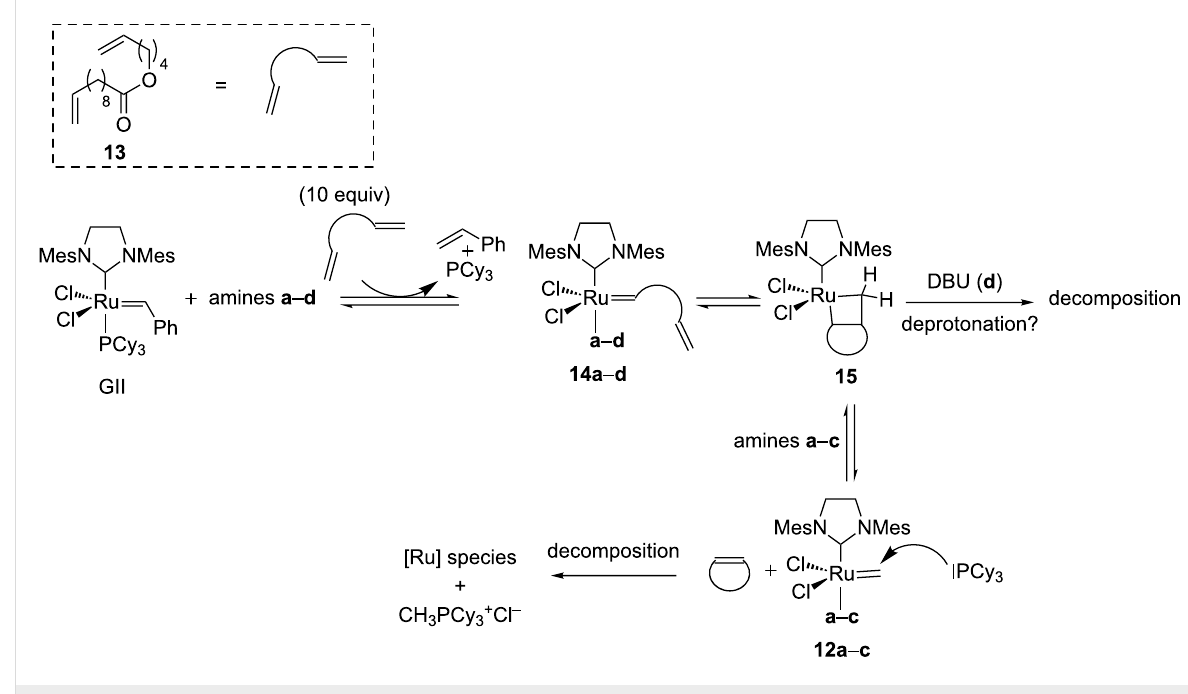
Scheme 6: Amine-induced decomposition of GII in RCM conditions.